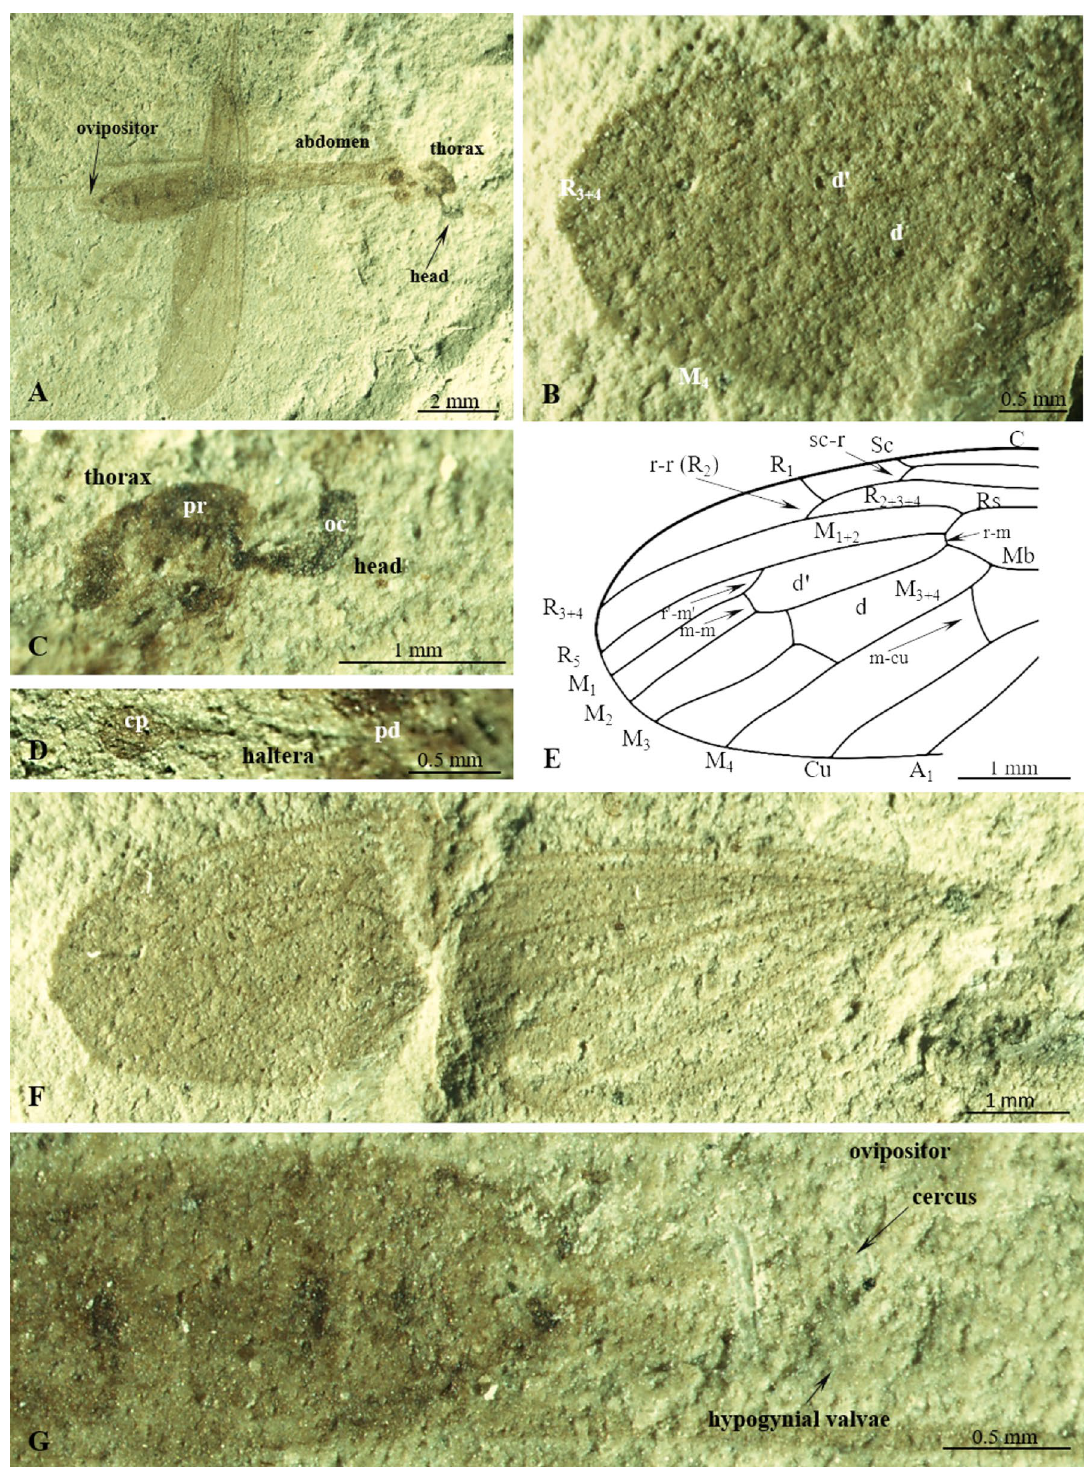
Figure 1. Cyttaromyia obdurescens Cockerell, 1925 27 , holotype No. 26284 (AMNH) (female): ( A ) habitus, lateral view; ( B ) apex of wing; ( C ) head and thorax, enlarged lateral view; ( D ) haltera; ( E ) apex of wing, drawing; ( F ) wing; C. terminal part of abdomen with ovipositor visible. cp, capitellum , pd, pedicellus of haltera, oc, ocellus , ped, pedicellus , pr, pronotum Material examined. Holotype MNHN.F.A71341 (18a, male); additional material 18b, female; 18c, female (on the same slab with holotype); Muséum national d’Histoire naturelle (MNHN), Paris; Green River Formation USA, Eocene.